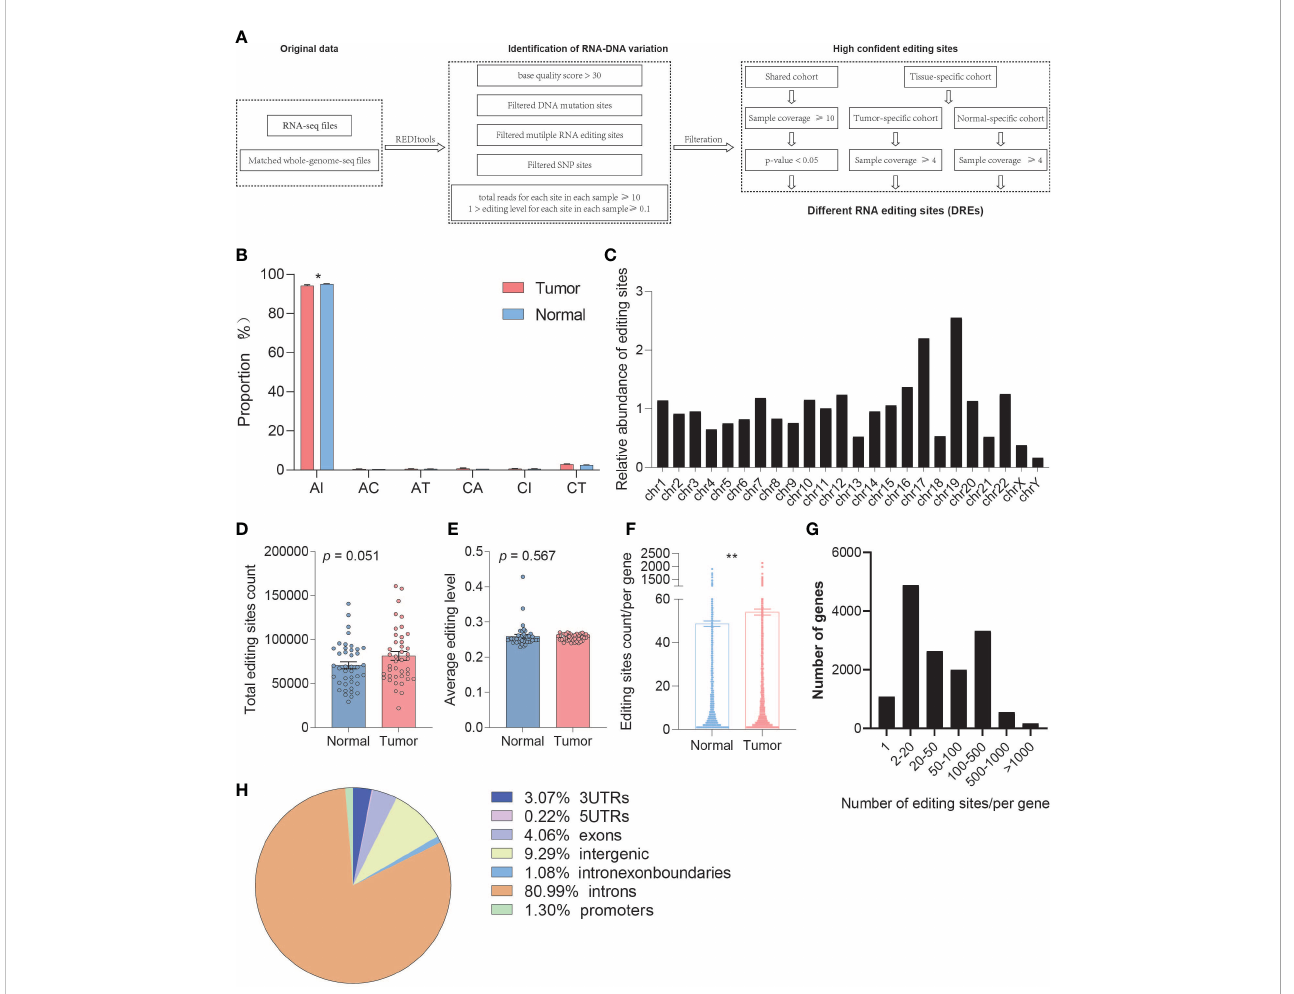
FIGURE 1 Comparison of the overall A-to-I RNA editing between paired tumor and normal samples. (A) The work fl ow for identi fi cation of editing sites with high con fi dence. (B) Genomic distribution of editing sites between normal and tumor samples. (C) The overall distribution of editing sites by chromosomes. (D) The change in editing count between normal and tumor samples. (E) The change in average editing level between normal and tumor samples based on REDItools. (F) The change in editing site count located in one gene between normal and tumor samples based on REDItools. (G) The overall distribution of editing site count located in one gene. (H) The distributions of RNA editing sites in different types of RNA regions. *p < 0.05, **p <